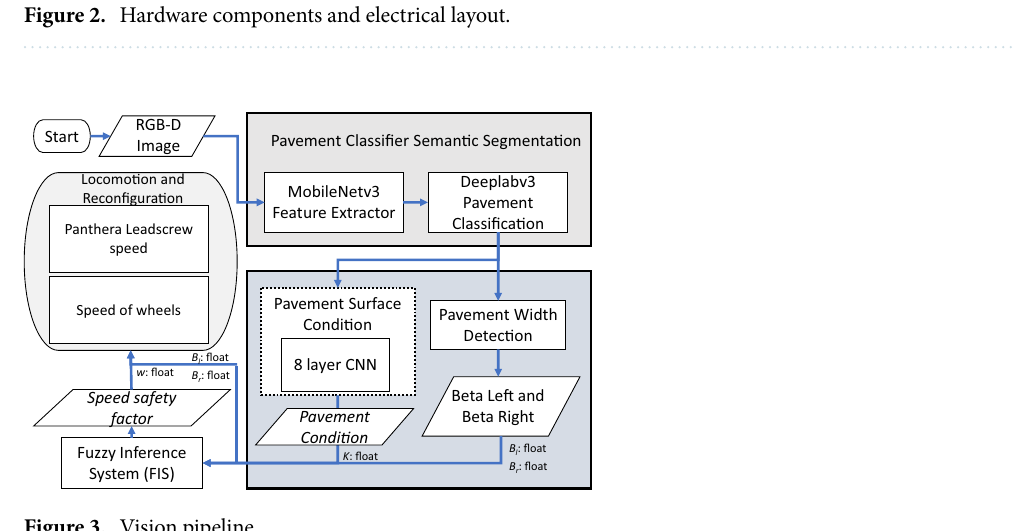
Figure 3. Vision